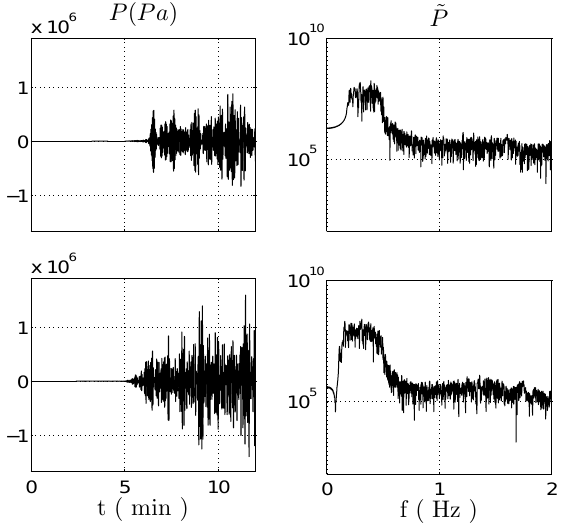
Figure 6. Pressure time series (left column) and their frequency spectra (right column) at Catania Test Site point (upper plots) and at Capo Passero point (lower plots), resulting from the numerical solution of the depth-integrated Eq. (5) over the whole